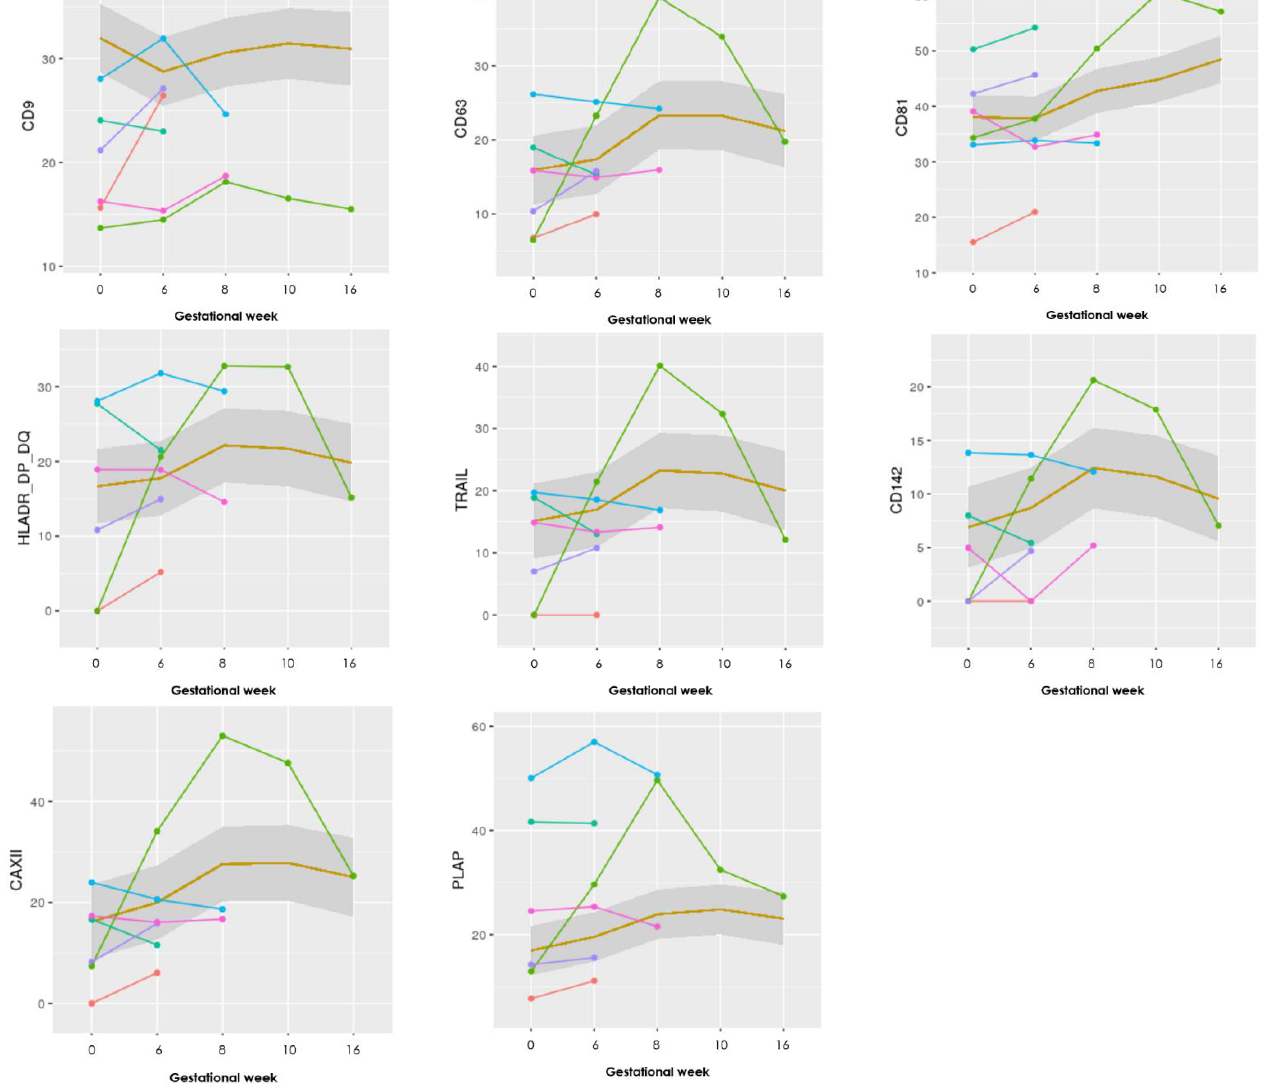
Figure 1. Graphs showing the progression of eight EV markers examined in the EV Array. The LB group ( n = 25) is illustrated as a mean within the grey box, whereas the PL group ( n = 6) is individually visualized with six different colors. Gestational week is depicted on the x-axis and absolute levels of the marker along the y-axis (the remaining nine markers can be seen in Appendix B).